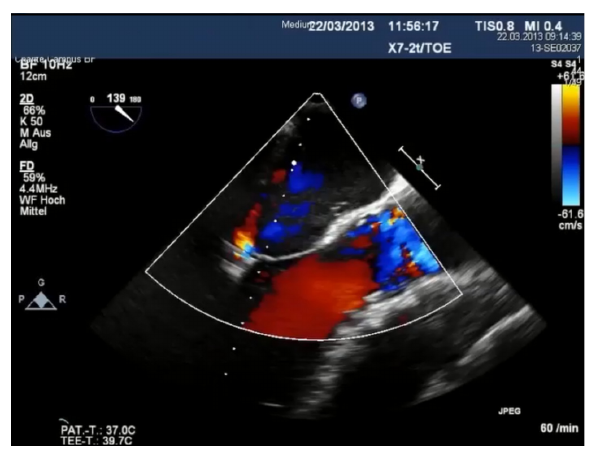
Supplementary Video 1 . Trans-esophageal three chamber view with residual mitral regurgitation after two